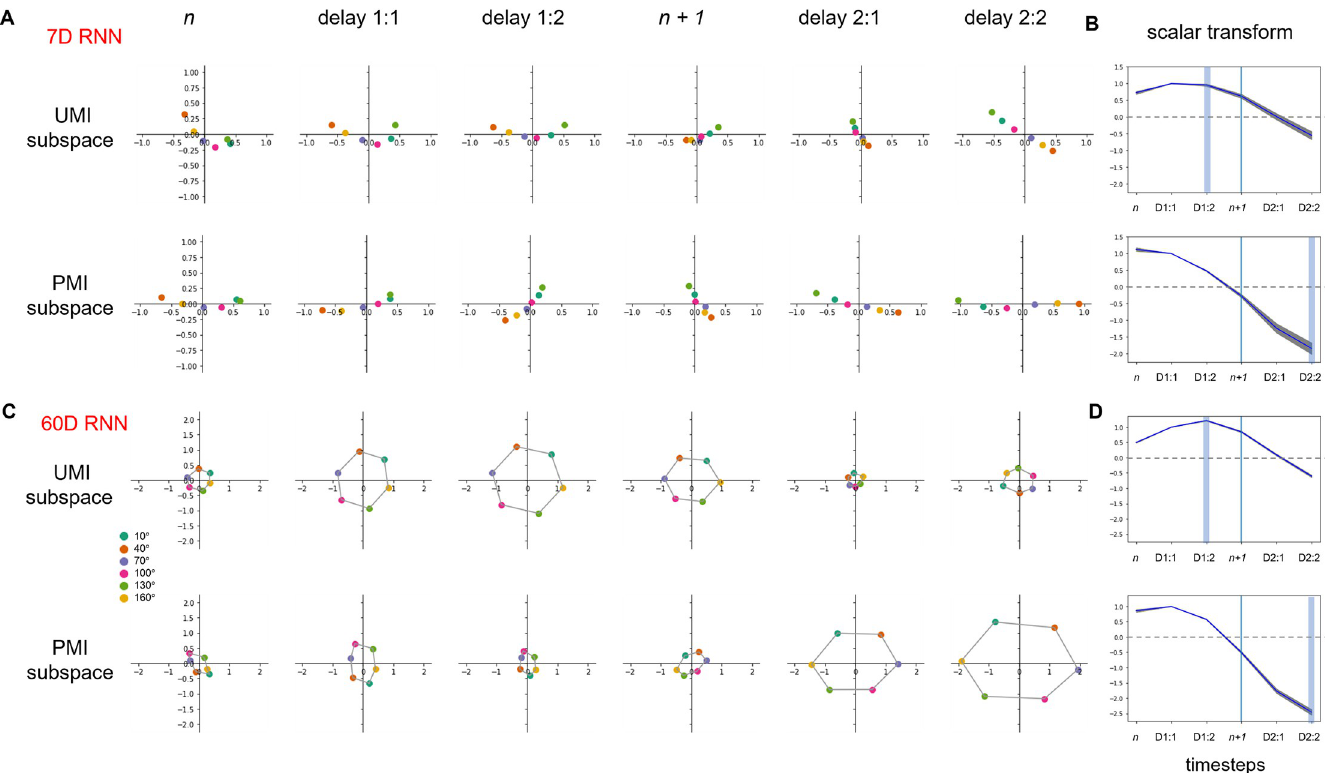
Fig 5. Stimulus trial-averages of RNN hidden layer activity projected into UMI and PMI subspaces over the course of a trial (stimulus n to delay 2 : 2 ). (A) Results from an example 7-hidden-unit network. Dot color indicates stimulus n ’s identity. (B) Time course of scalar transform over the course of a trial, averaged across 10 networks. Blue vertical line indicates the timestep when stimulus n + 1 is presented. Light blue shading shows the timesteps that were used to identify the dPCs. The gray shading around the curve indicates standard error of the mean. The gray dashed lines indicate a scalar transform of 0; the stimulus representational format is reversed after crossing this line. (C, D) Same as (A, B) but for the 60-hidden-unit RNNs. In C, data points of adjacent stimulus orientation angles are connected by a gray line.